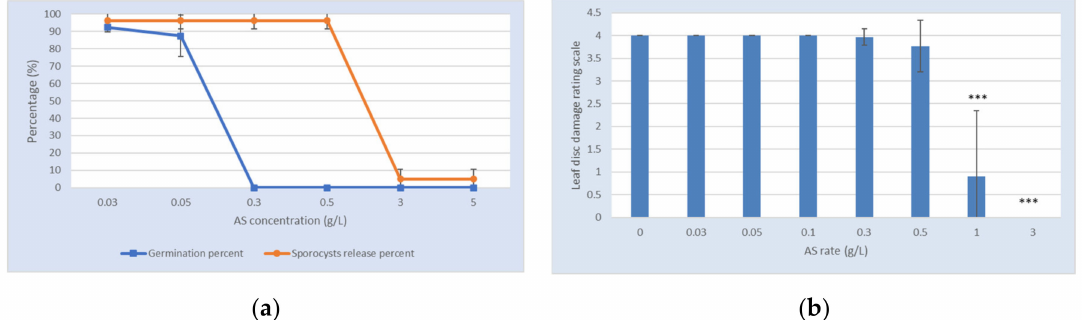
Figure2. Thedirecte ff ectoftheactivesubstance(AS).Theresultsareexpressedasthemean +/ − standard deviation. ( a ) Evaluation of sporocyst release and zoospore germination in microplates in the presence of increasing doses of AS on P. viticola . The orange line represents the percentage of sporocyst release, while the blue represents the percentage of zoospore germination. The AS concentration ranged from 0.03 to 5 g / L. ( b ) Evaluation of the damages caused by P. viticola in the presence of increasing doses of AS on leaf grapevine discs. The AS concentration ranged from 0.03 to 3 g / L. The leaf disc damage rating scale is an arbitrary scale ranging from 0 (no damage) to 4 (completely damaged). ***: p <